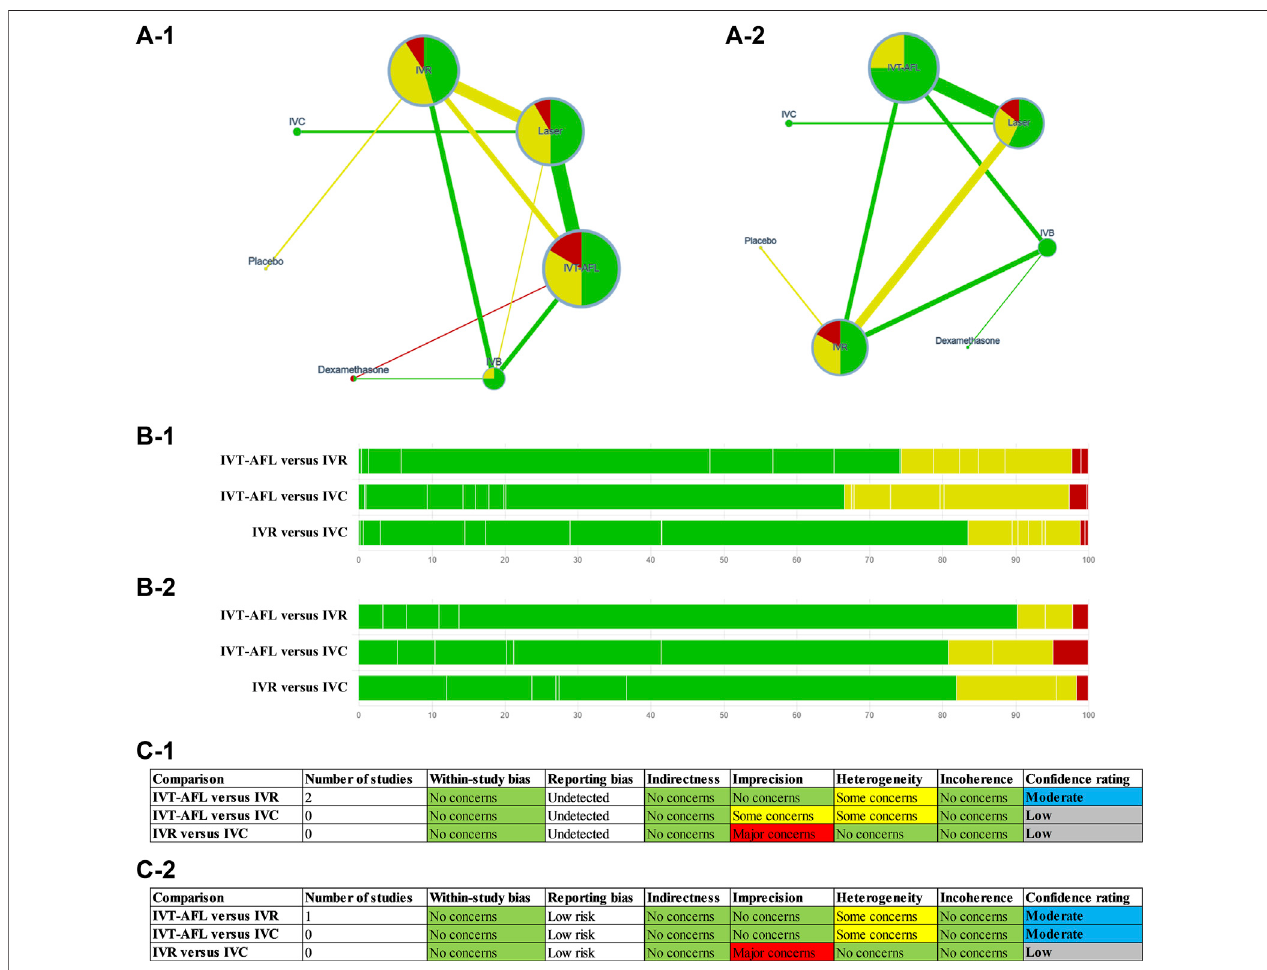
FIGURE 4 | GRADE for the primary outcomes (A-1, B-1, C-1) are for the outcome BCVA (ETDRS letters) mean change from baseline; (A-2, B-2, C-2) are for the proportion of patients with a gain of at least 15 ETDRS letters. Notes: (A) Summary of study limitations of the included randomized controlled trials (RCTs). The colors in the circles indicate the percentage of low risk of bias RCTs (green), moderate risk of bias RCTs (yellow), and high risk of bias RCTs (red) involving each intervention. The colors of the line then indicate the summative risk of bias assessment of each comparison based on the above information – low risk of bias comparison (green), moderate risk of bias comparison (yellow), high risk of bias comparison (red). (B) Contribution of risk of bias comparisons to focus comparison estimates (between IVT- AFL,IVR,andIVC). (C) Tableofdomainsfordowngrading.BCVA,best-correctedvisualacuity;ETDRS,EarlyTreatmentDiabeticRetinopathyStudy;GRADE,Gradingof Recommendations Assessment, Development and Evaluation; IVC, intravitreal conbercept; IVR, intravitreal ranibizumab; IVT-AFL, intravitreal a fl